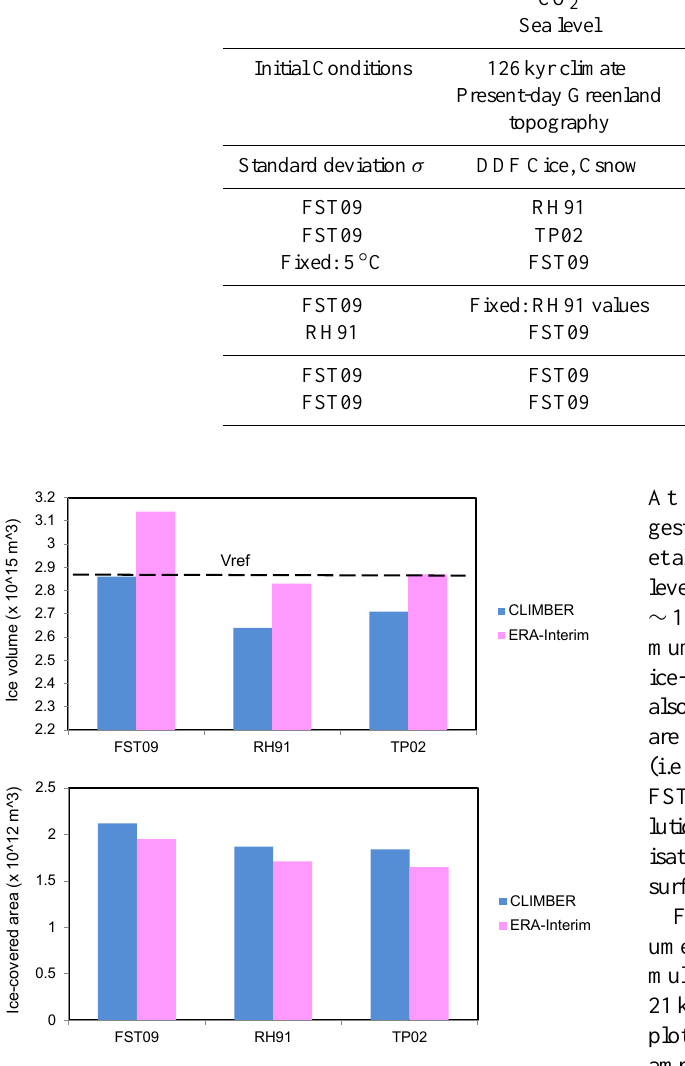
Fig. 2. Magnitude of the ice volumes (top panel) and ice-covered areas (bottom panel) obtained at the end of the present-day simula- tions forced either with CLIMBER (runs 4 to 6) or with the climatic variables coming from the ERA-Interim dataset (runs 7 to 9). The dotted black line in the top panel represents the magnitude of the initial ice volume ( V ref = 2.88 × 10 15 m 3 ) coming from Bamber et al. (2001) and interpolated on the GRISLI model